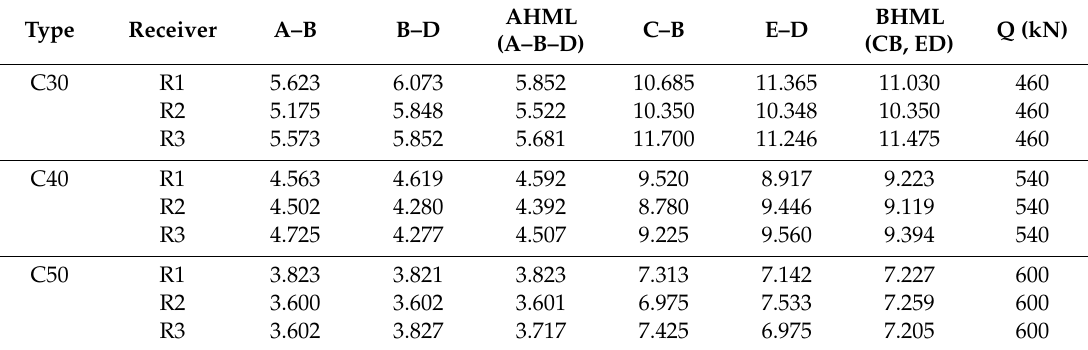
Table 2. A database of the concrete acoustoelastic modulus β (unit: 10 − 4 /